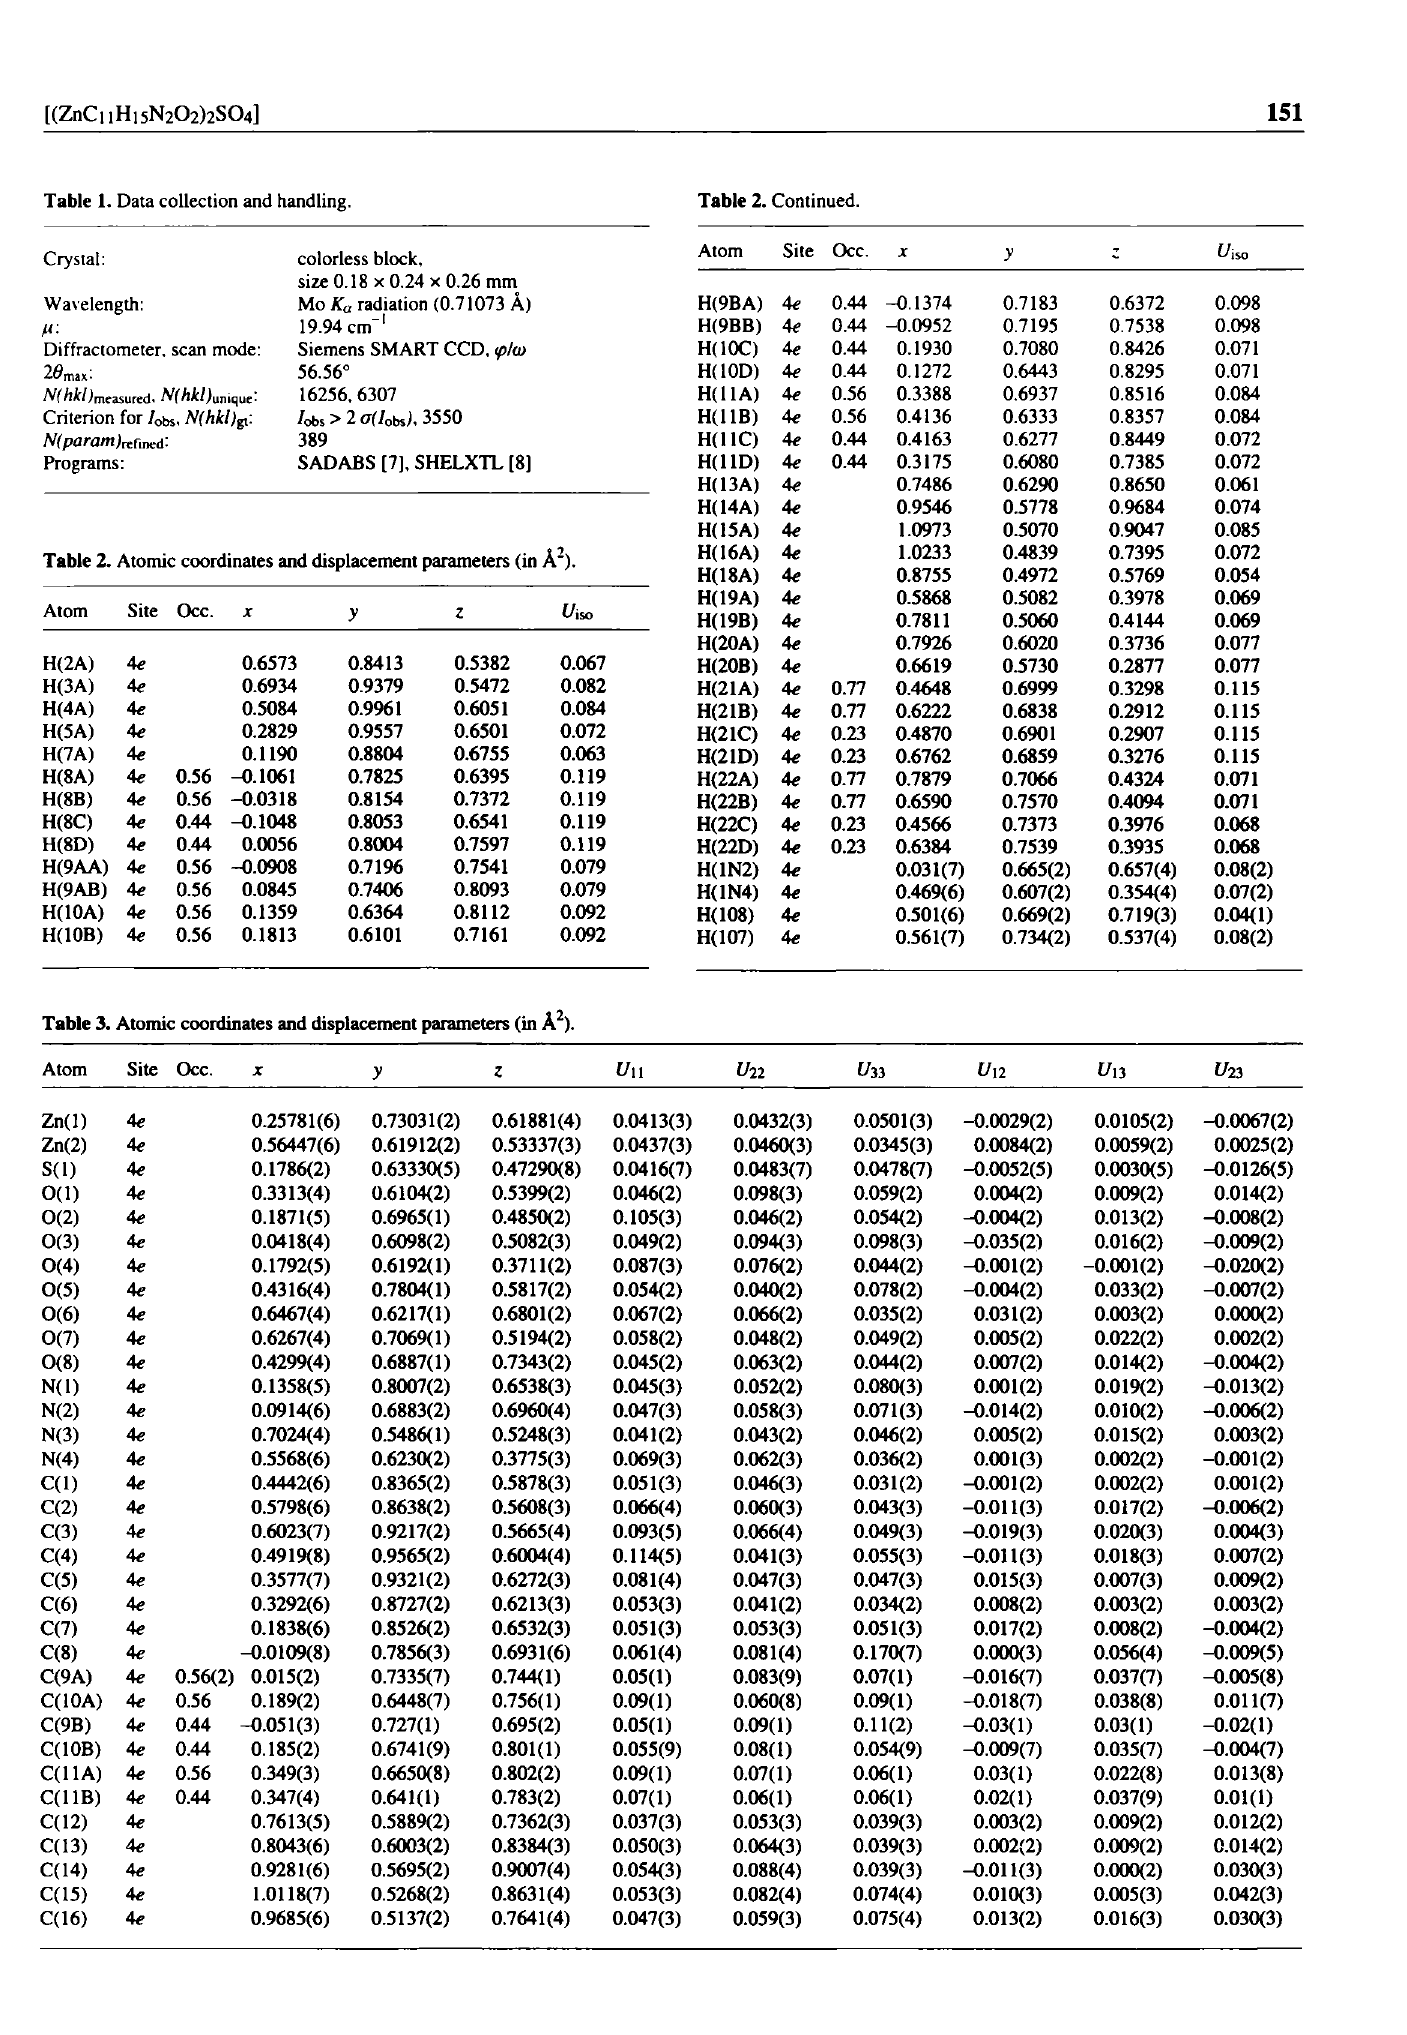
Table 3. Atomic coordinates and displacement parameters (in Â 2